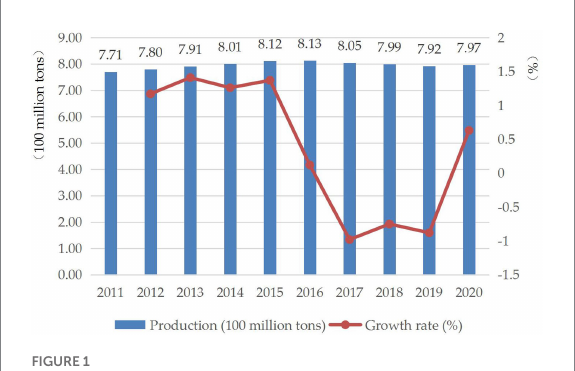
FIGURE 1 Production and growth rate of straw in China from 2011 to